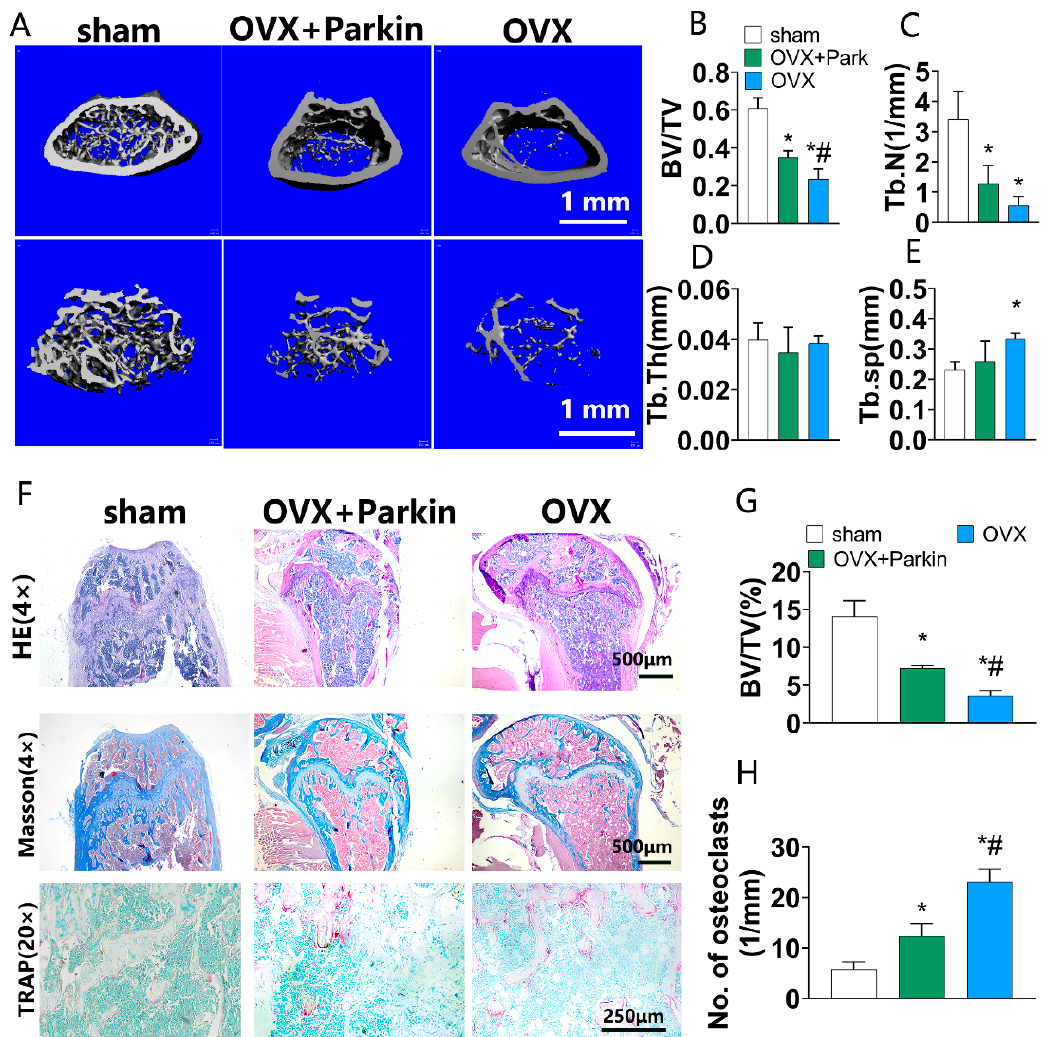
Figure 5. Parkin delayed the progression of OVX-induced bone loss in vivo. ( A ) Representative microcomputed tomography images of mouse distal femur. Scale bars = 1 mm. ( B – E ) Quantification of BV/TV, Tb.N, Tb.Th, and Tb.Sp. ( F ) Histologic analyses by H&E, Masson’s, and TRAP staining. ( G ) BV/TV of sections quantified using ImageJ. * p < 0.05 compared with the sham group, # p < 0.05 compared with the OVX group. ( H ) Number of TRAP (+) cells. * p < 0.05 compared with the sham group; # p < 0.05 compared with the OVX